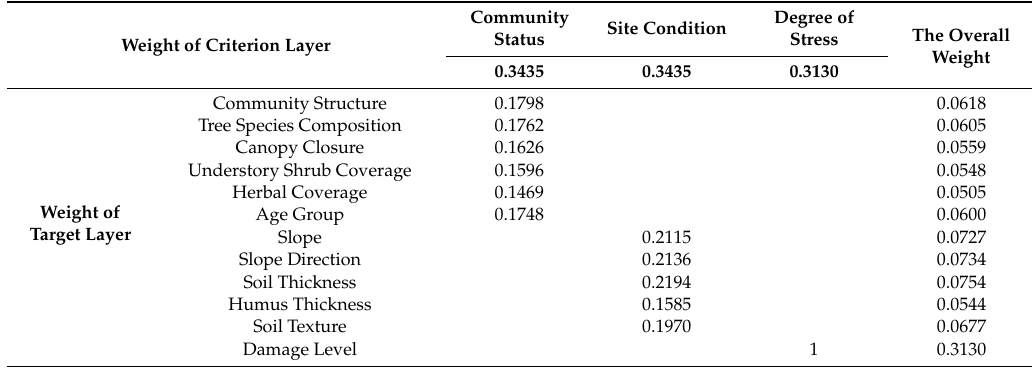
Table 6. Weightsof di ff erent indices and